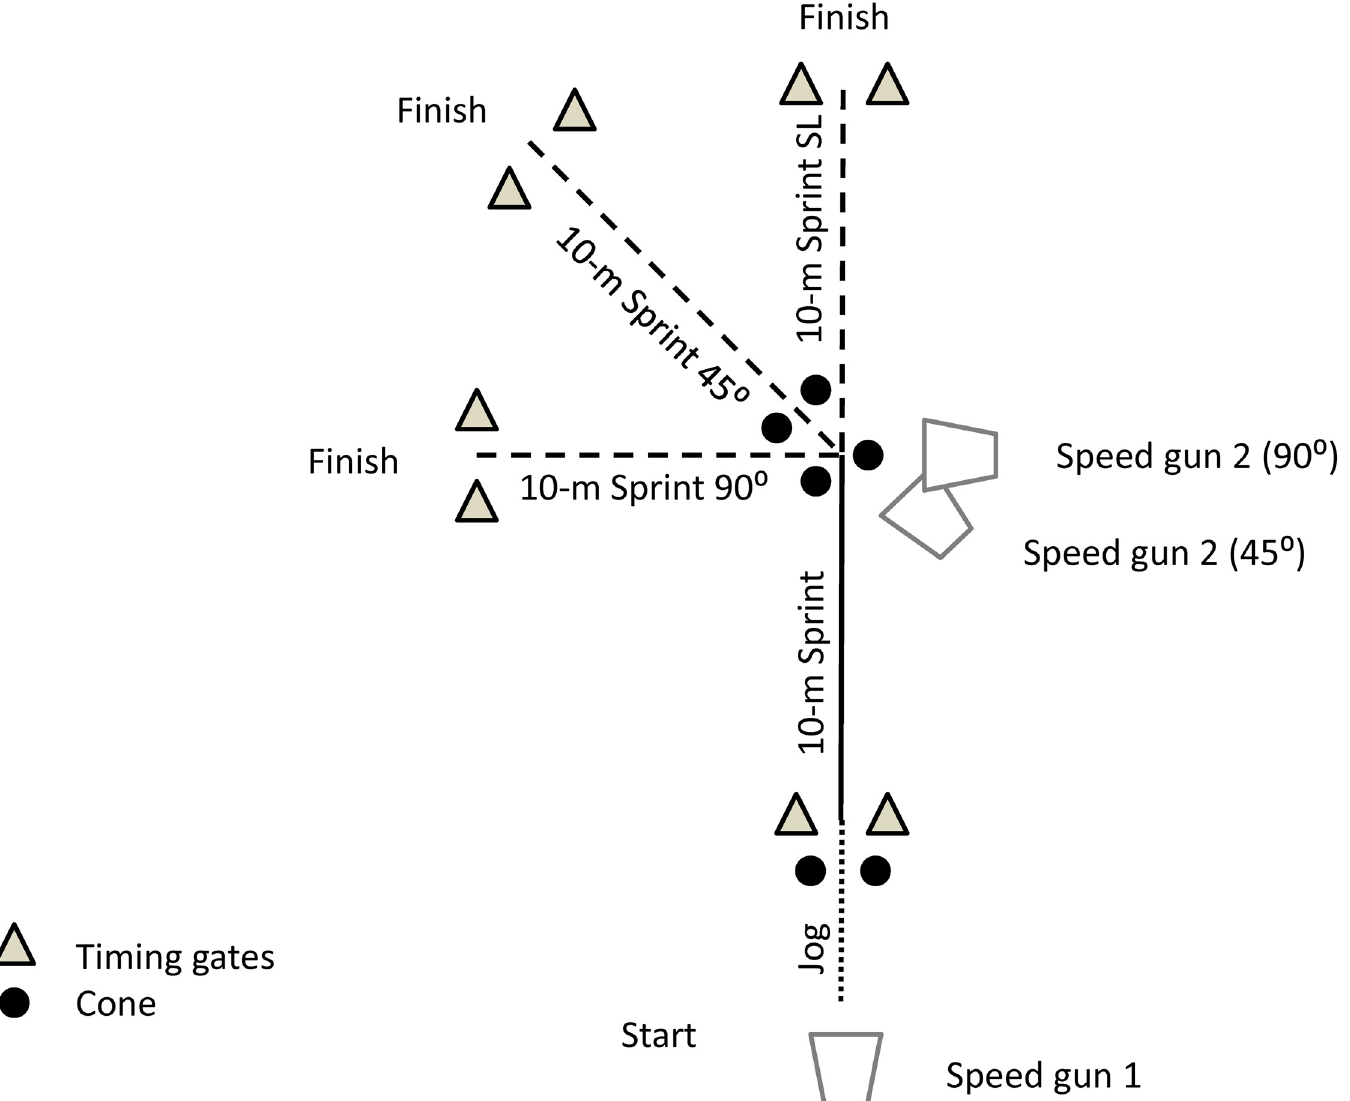
Fig 1. Experimental set up with the new timing methodology combining two speed guns synchronized. See methods for